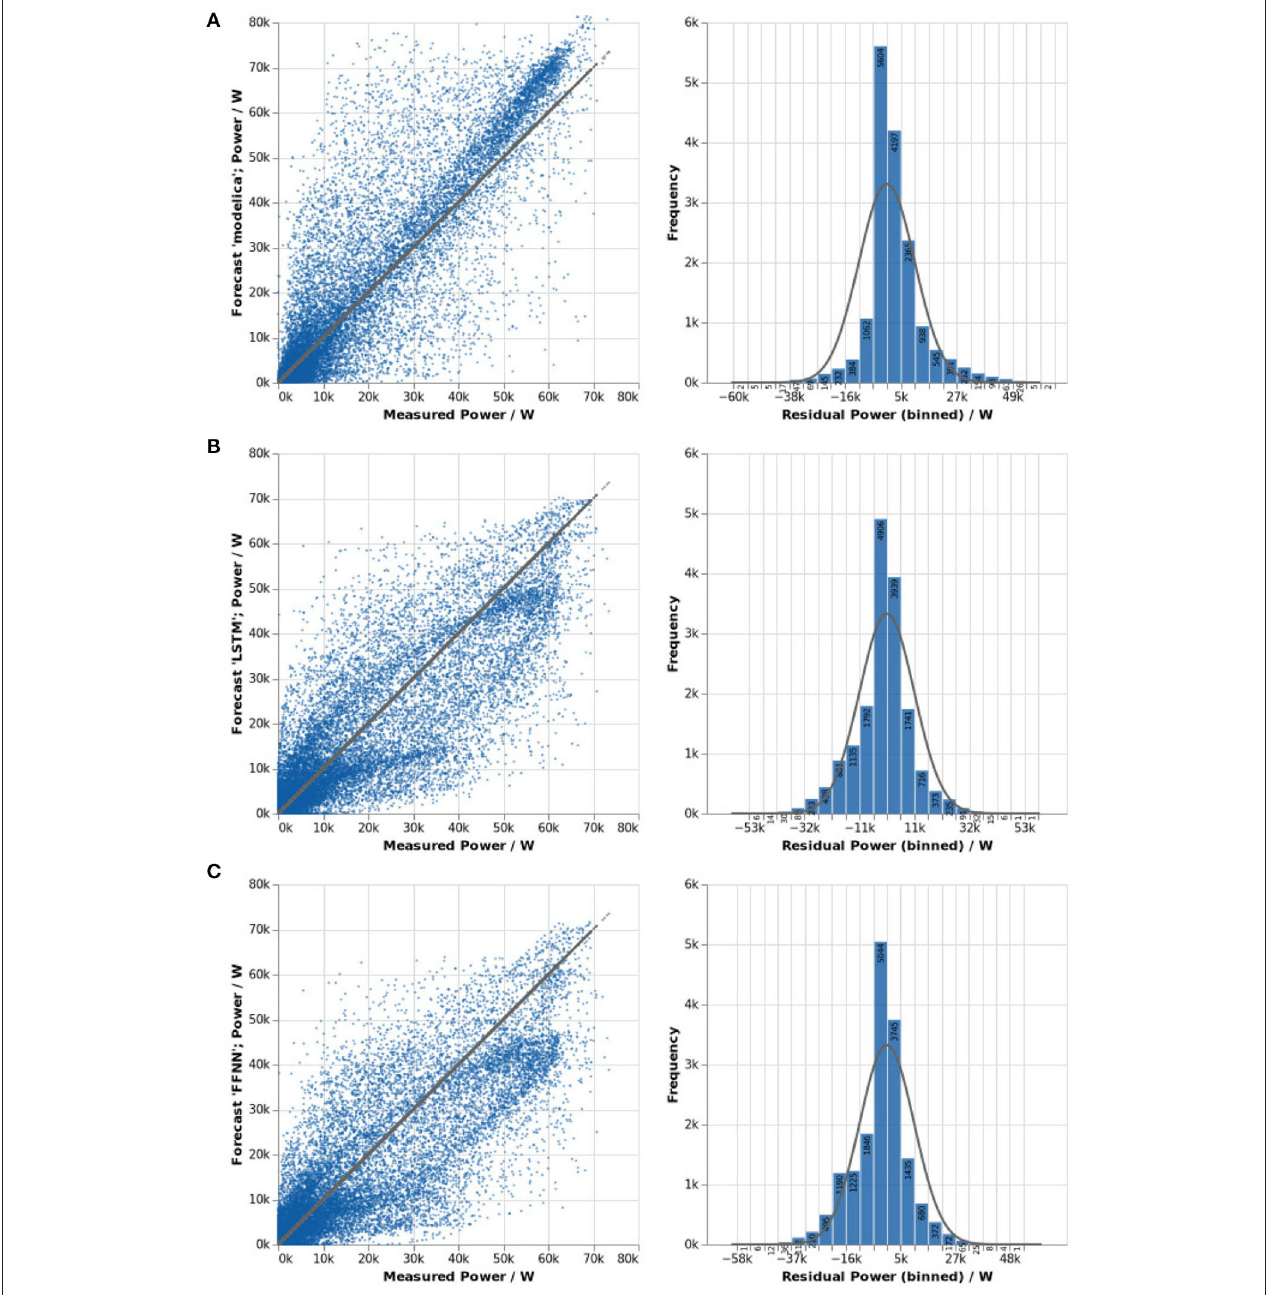
FIGURE 5 | Forecast quality of the power forecast for site swsls-sw for 2019: physics-based (A) , LSTM (B) , and FFNN (C) .